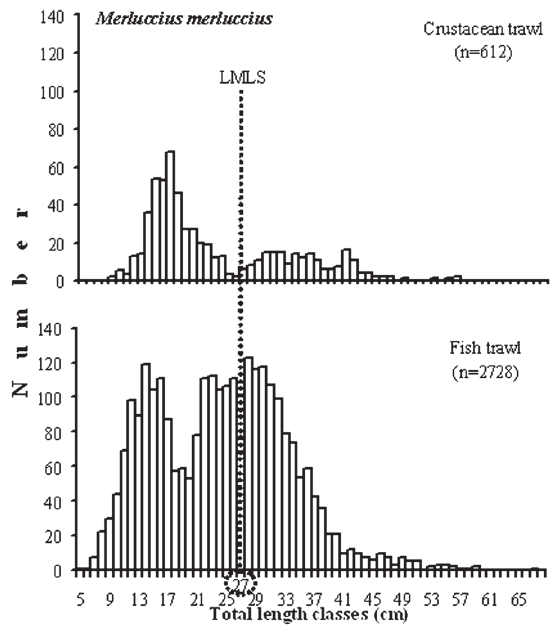
Fig . 8. – length frequency distribution of the fish trawl target spe- cies Merluccius merluccius (European hake) (lMls=legal Mini- mum landing